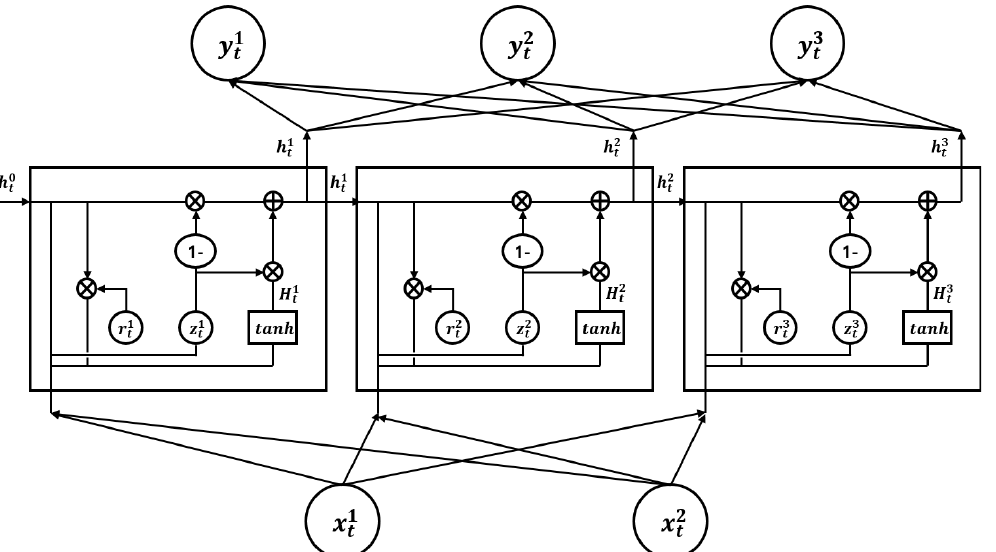
Figure 5. An architecture of Gated Recurrent Unit networks by